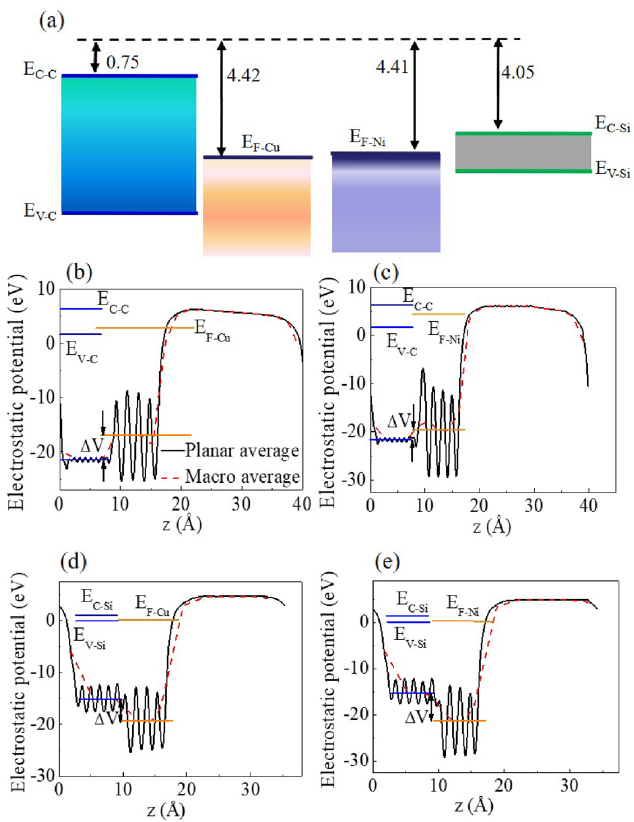
Figure 2. ( a ) Energy band alignment for the Cu, Si, Ni and diamond according to the experimental values of electron affinity and work function. Planar and macroscopic average of the electrostatic potential as a function of the position along the z direction for ( b ) the Cu–C, ( c ) the Ni–C, ( d ) the Cu–Si, ( e ) the Ni–Si interfaces. The E C–C and E C–Si are the conduction band bottom and E V–C and E V–Si are valence band top for diamond and Si, respectively. The E F–Cu and E F–Ni are Fermi level of Cu and Ni, respectively. The ΔV is the difference of macroscopic average of the electrostatic potential for these